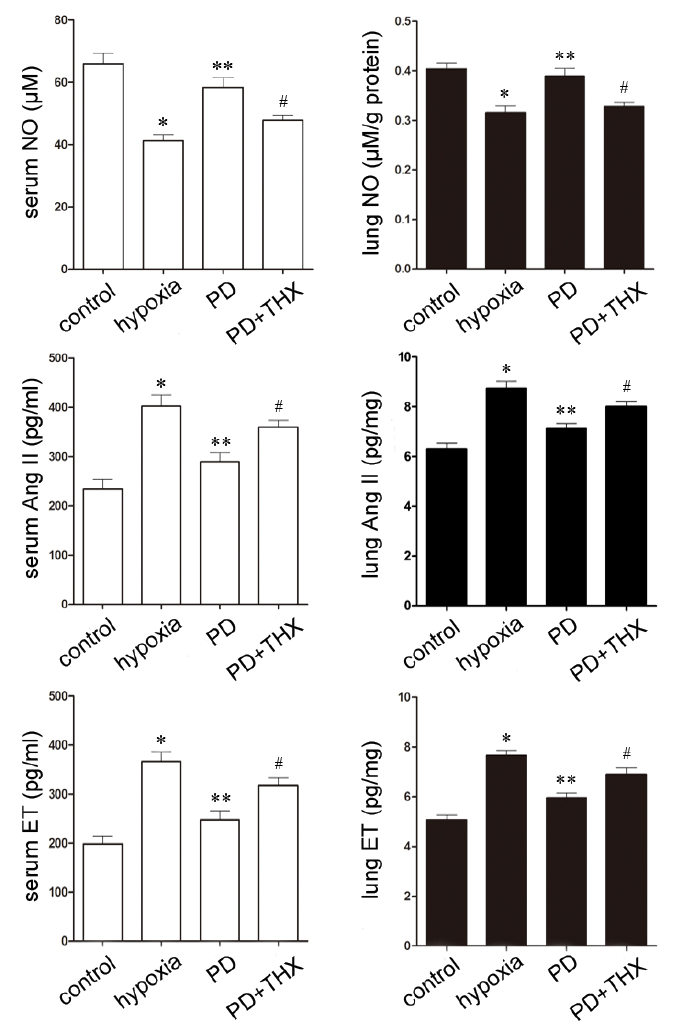
Figure 4. Effects of high dose polydatin on NO, Ang II and ET in the serum and lung samples. n = 8. Control: normoxic group; Hypoxia: hypobaric and hypoxic group; PD: 20 mg/kg polydatin group; PD + THX: 20 mg/kg polydatin and 0.2 mg/kg THX group. * p < 0.05 vs. control; ** p < 0.05 vs.